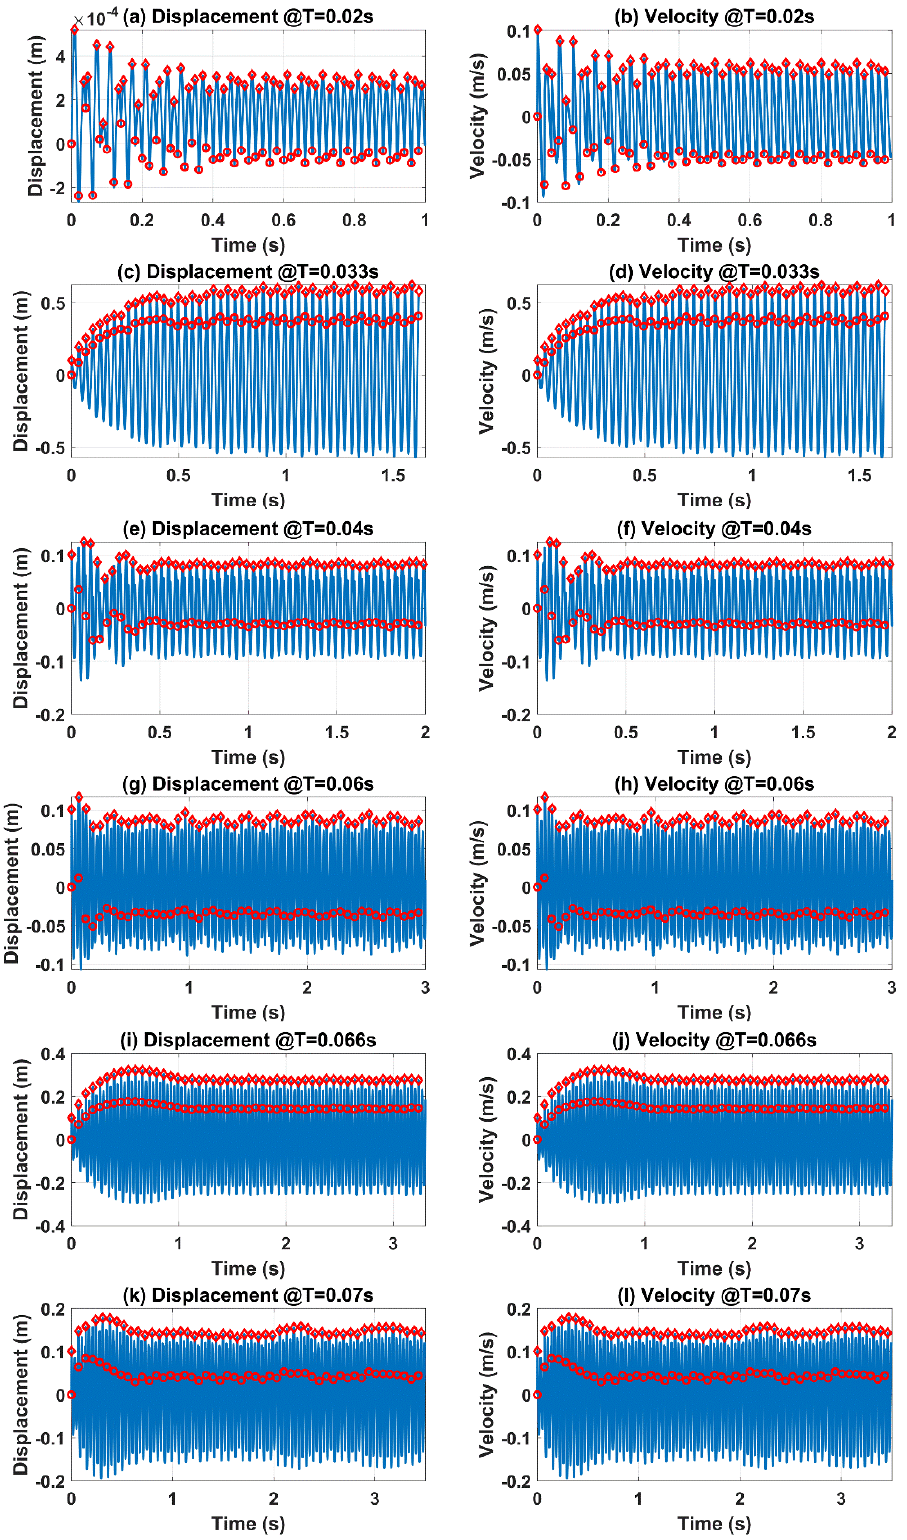
Figure 2. Calculated time traces of displacement ( a , c , e , g , i , k ) and velocity ( b , d , f , h , j , l ) at different rotation speeds.